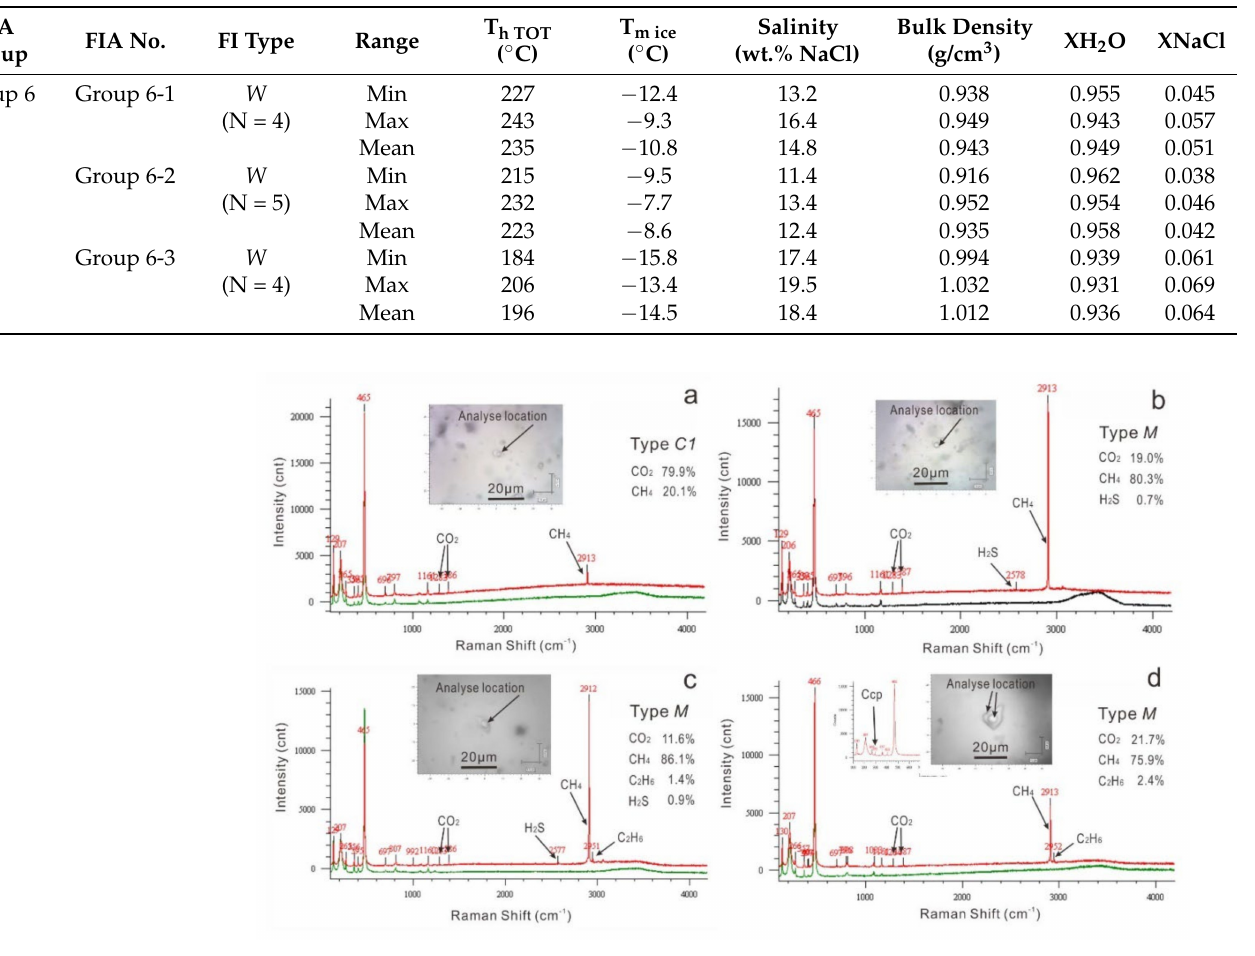
Figure 7. Laser Raman spectra of vapor bubbles (red color), aqueous (green color), or daughter minerals (in the d figure) of fluid inclusions in the Sanakham gold deposit. ( a ), Type C1 inclusion; ( b – d ), type M inclusion.4.4. Composition and Density of Fluid